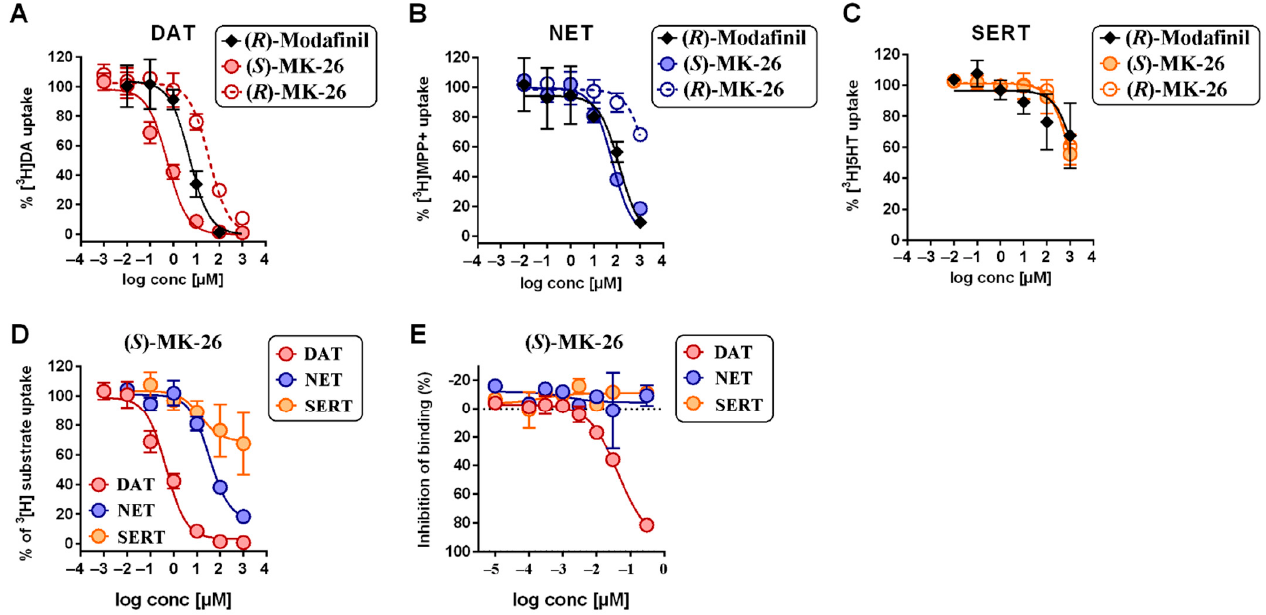
Figure 2. Uptake inhibition and radioligand binding assays. ( A ) Uptake inhibition of ( S )-MK-26, ( R )- Modafinil, and ( R )-MK-26 at DAT (red); ( B ) NET (blue); ( C ) SERT (yellow) stably expressed in HEK293 cells. Uptake substrates used were 0.15 µM [ 3 H]DA, 0.05 µM [ 3 H]MPP+, and 0.1 µM [ 3 H]5-HT, respectively. ( D ) Selectivity profile of ( S )-MK-26 at DAT, NET and SERT in the substrate uptake-inhibition assay. Data are mean ± SD. ( E ) Binding affinity of ( S )-MK-26 on DAT, NET, and SERT expressed in CHO cells. Effects were determined by specific antagonist radioligand assays. IC 50 values and details in the main text. IC 50 values are derived from non-linear regression using the equation Y = Bottom + (Top − Bottom)/(1 + 10ˆ((X − LogIC 50